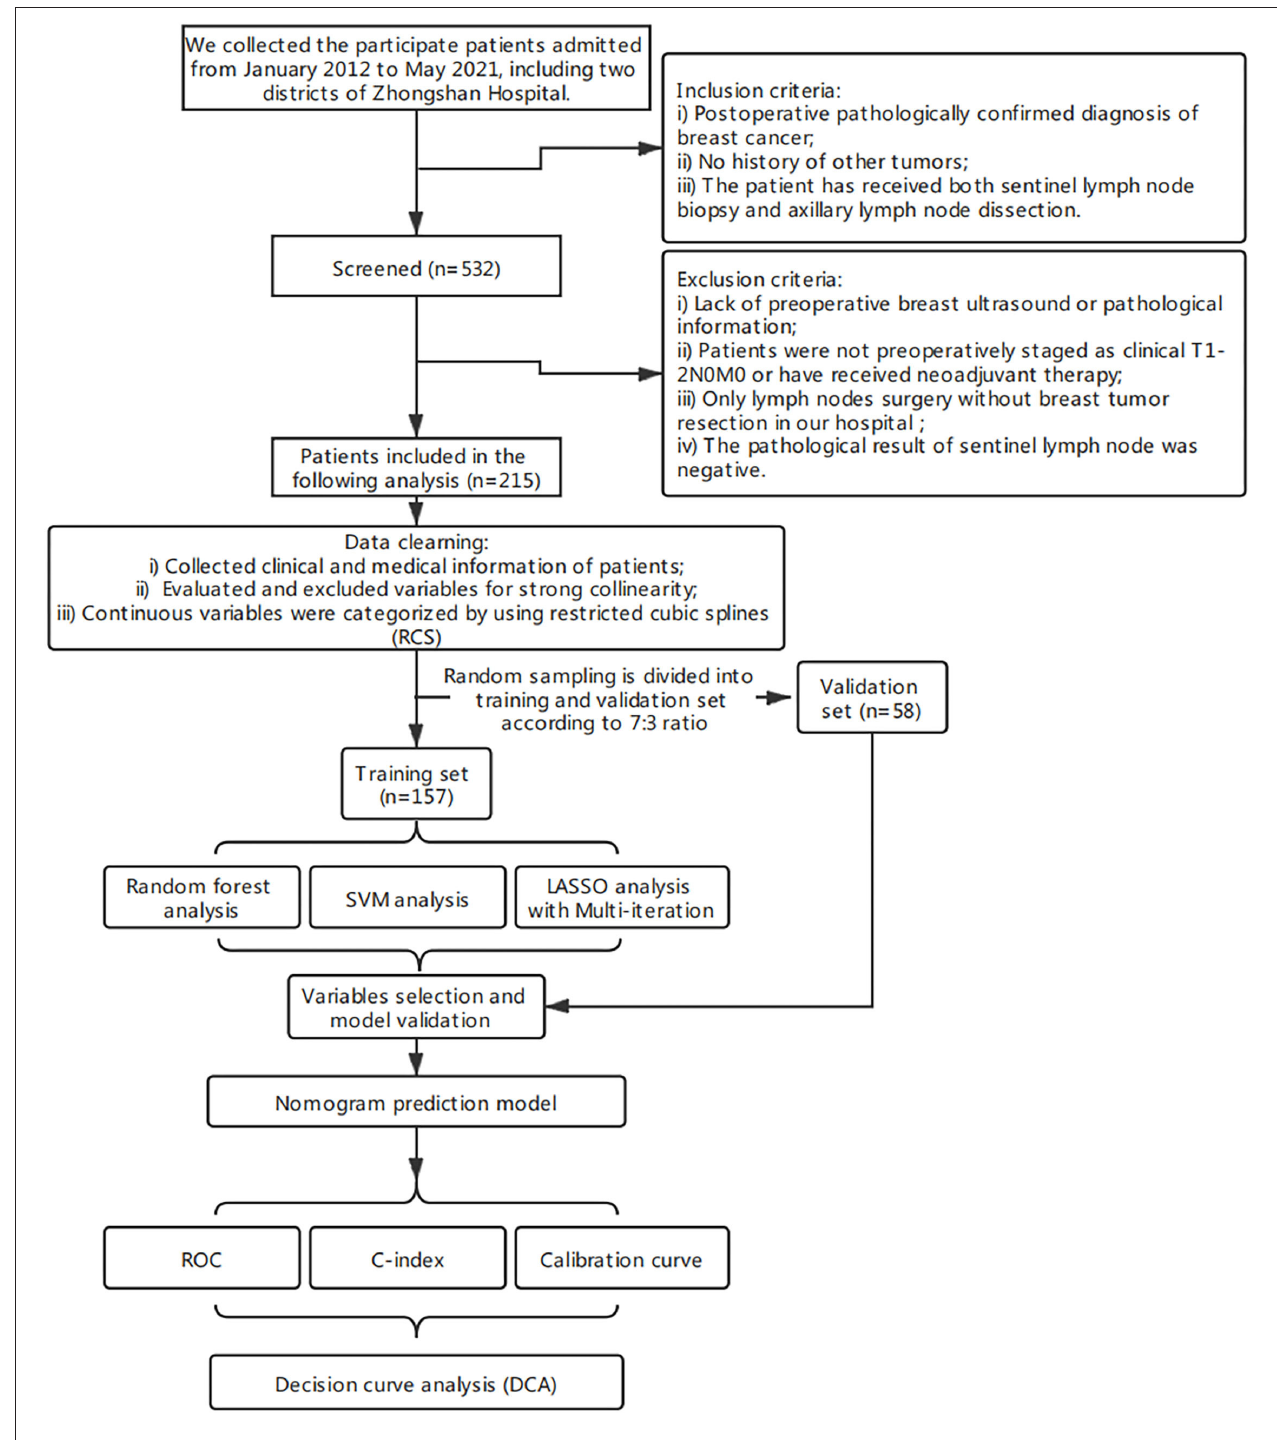
FIGURE 1 | The working flow of this